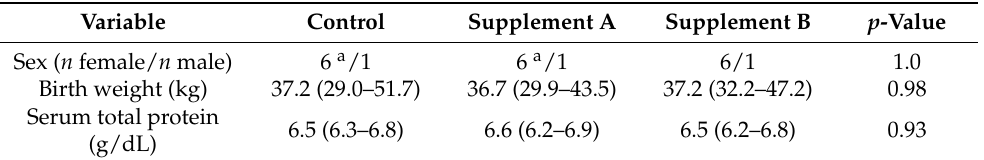
Table 1. Distribution of sex and median (range) values of birth weight and serum total protein at 1 week of age across treatment groups.